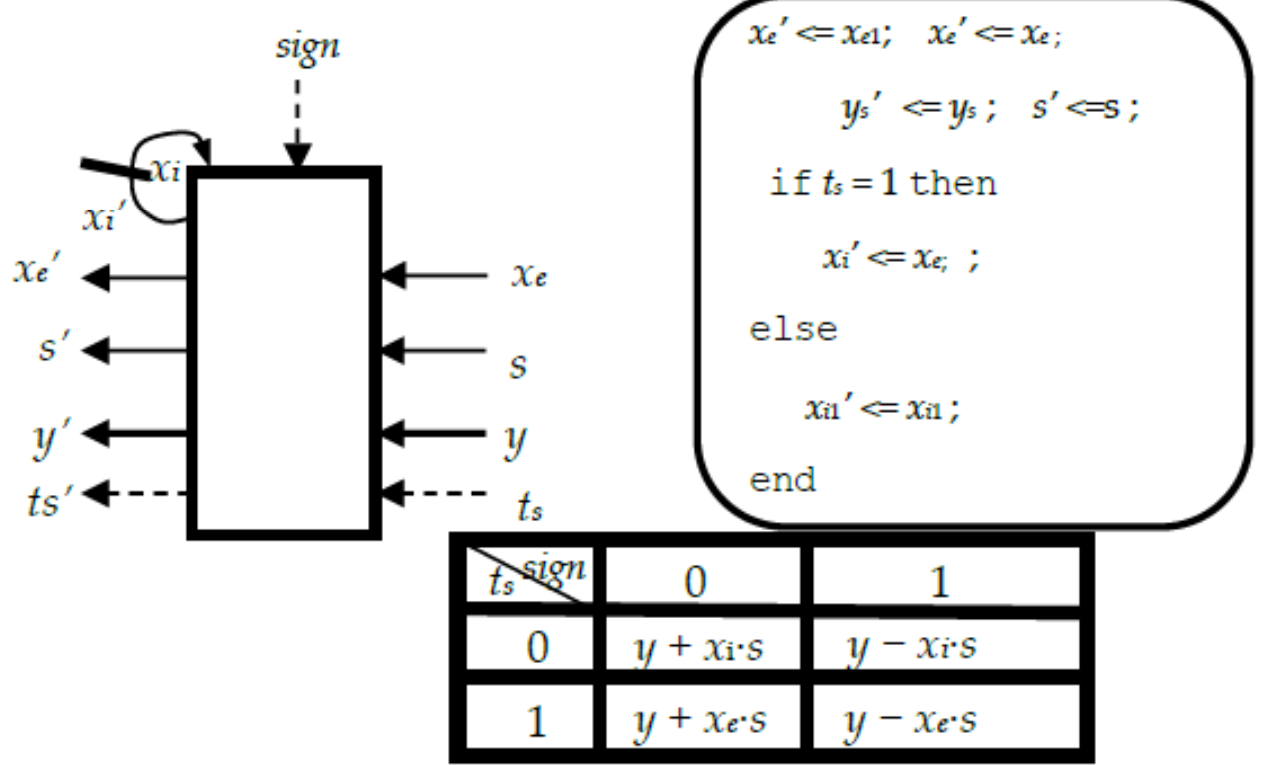
Figure 6. The function of the processing elements PE from Figures 7 – 10.